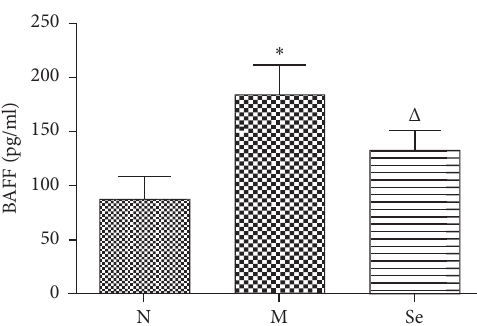
Figure 3: Serum BAFF level detected by ELISA. ∗ P < 0 . 05 compared to the N group. △ P < 0 . 05 compared to the M group.